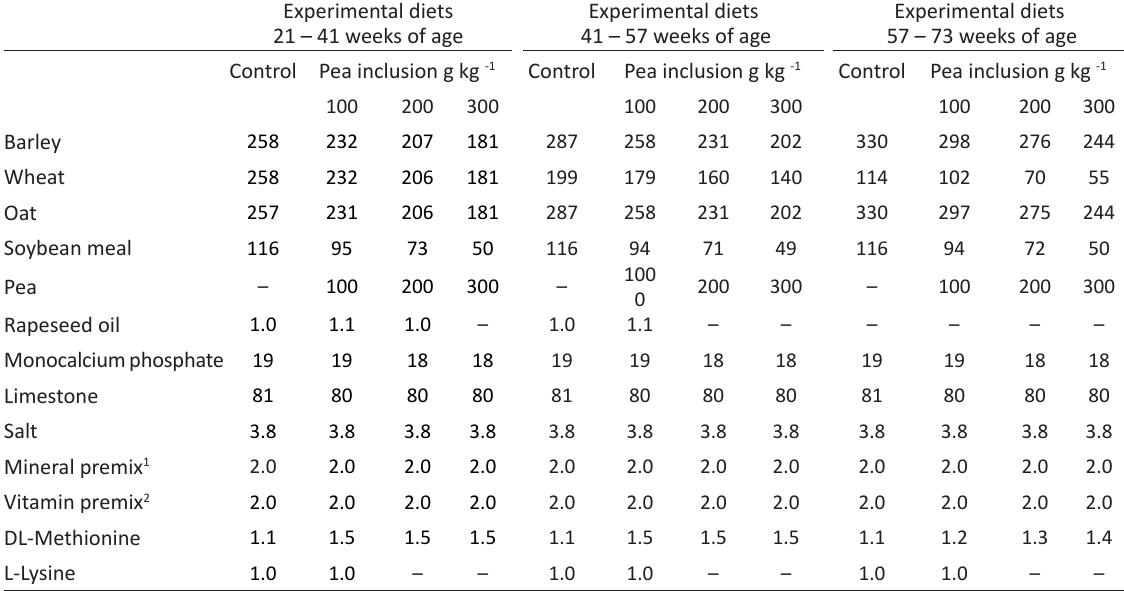
Table 1. Composition of experimental diets (g kg -1